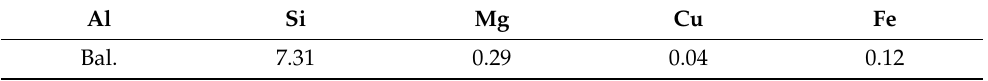
Table 4. Chemical composition (wt.%) of A356 aluminum-silicon alloy used in this research. Al Si Mg